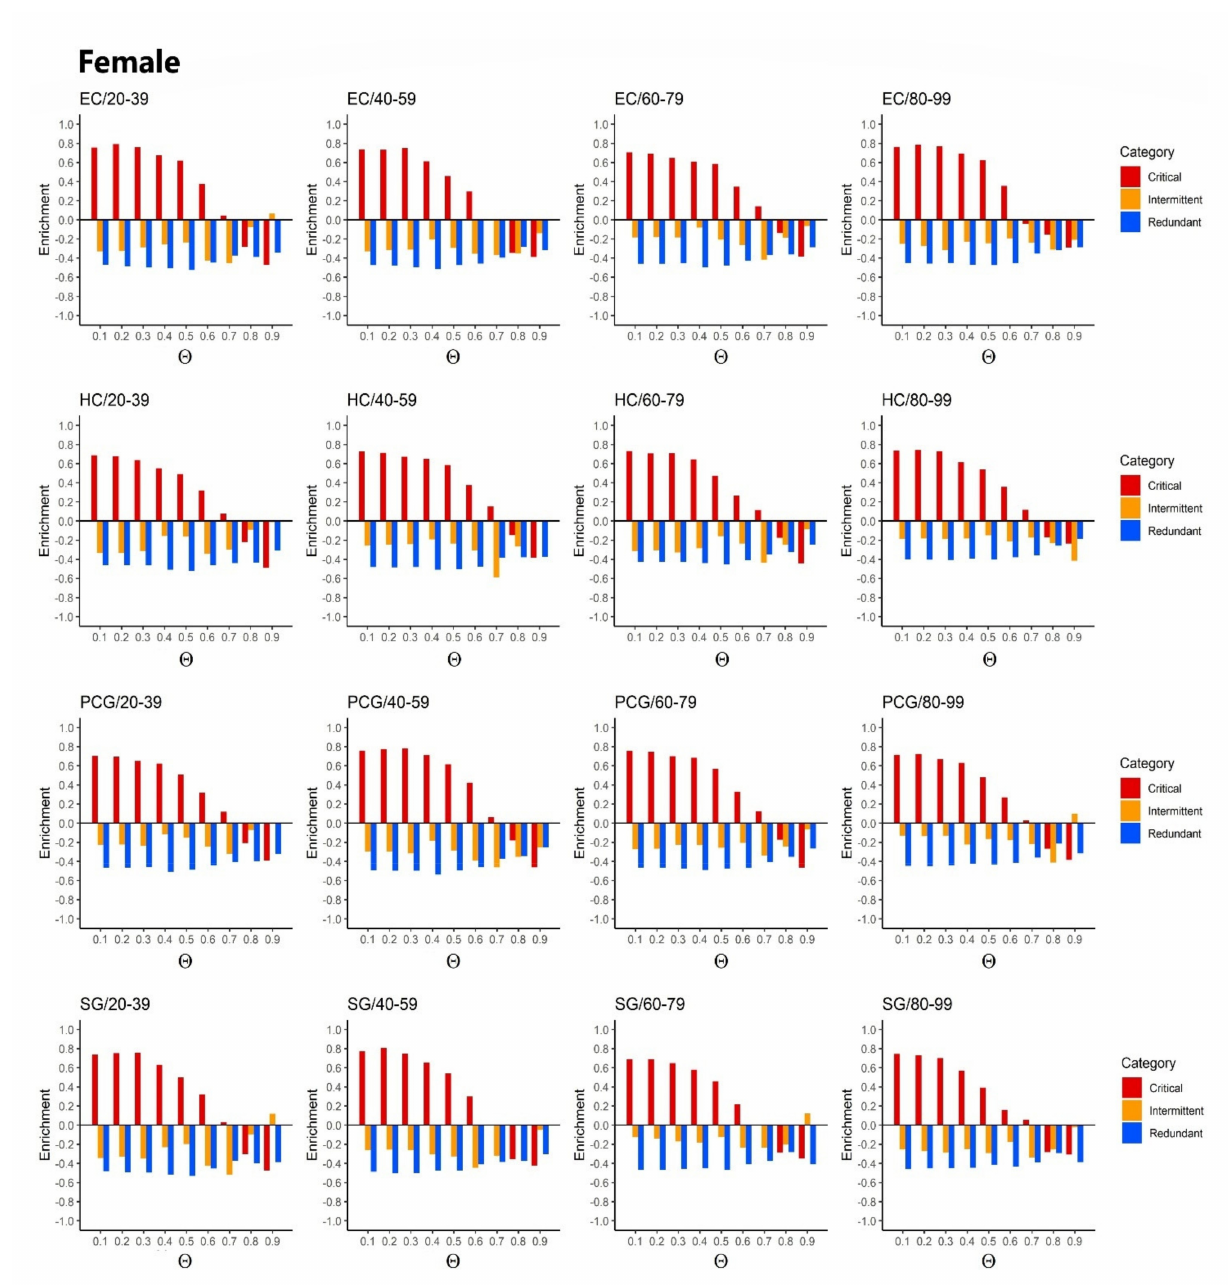
Figure 7. Enrichment values for the association of proteins with well-known ageing genes vs. each threshold probability Θ . The figure shows the results for female samples and all four brain regions and all age periods. The associated p -values, calculated using a two-tailed Fisher’s exact test, are shown in Table S2 (Excel